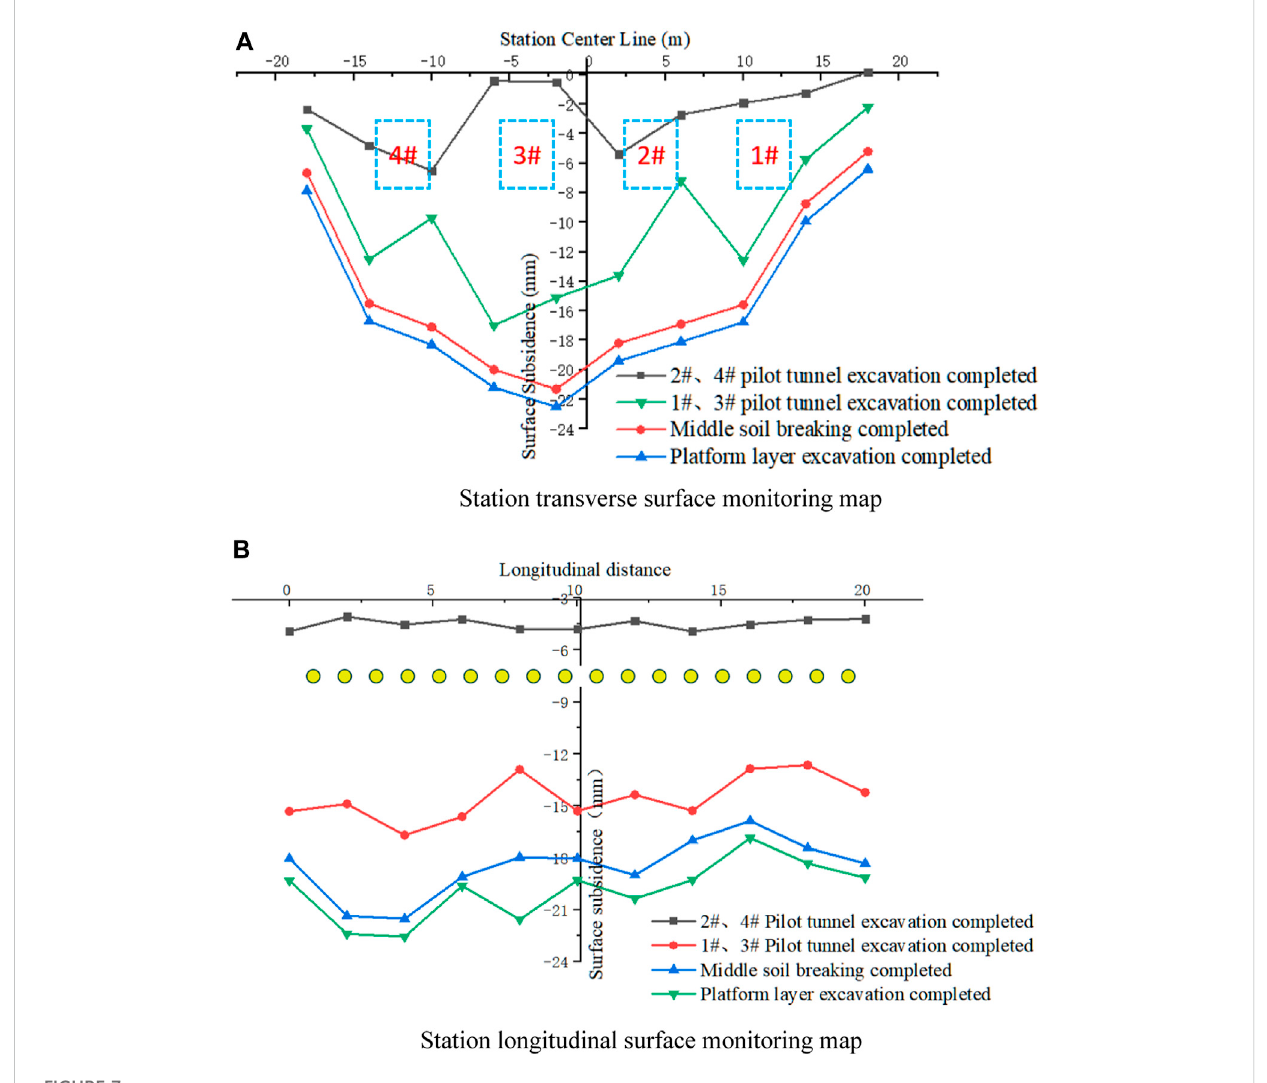
FIGURE 7 Measured fi eld